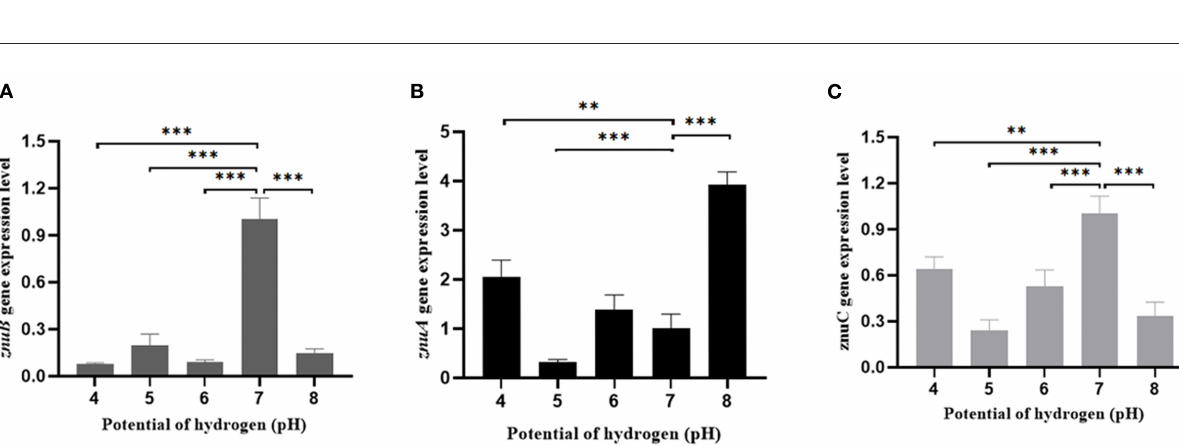
FIGURE9 The expression levels of znuA , znuB and znuC gene under different potential of hydrogen. (A) was the expression levels of znuA gene at pH = 4, 5, 6, 7 and 8; (B) was the expression levels of znuB gene at pH = 4, 5, 6, 7 and 8; (C) was the expression levels of znuC gene at pH = 4, 5, 6, 7, and 8. Data were presented as mean ± standard deviation (SD) ( n = 3). ** P < 0.01, *** P <